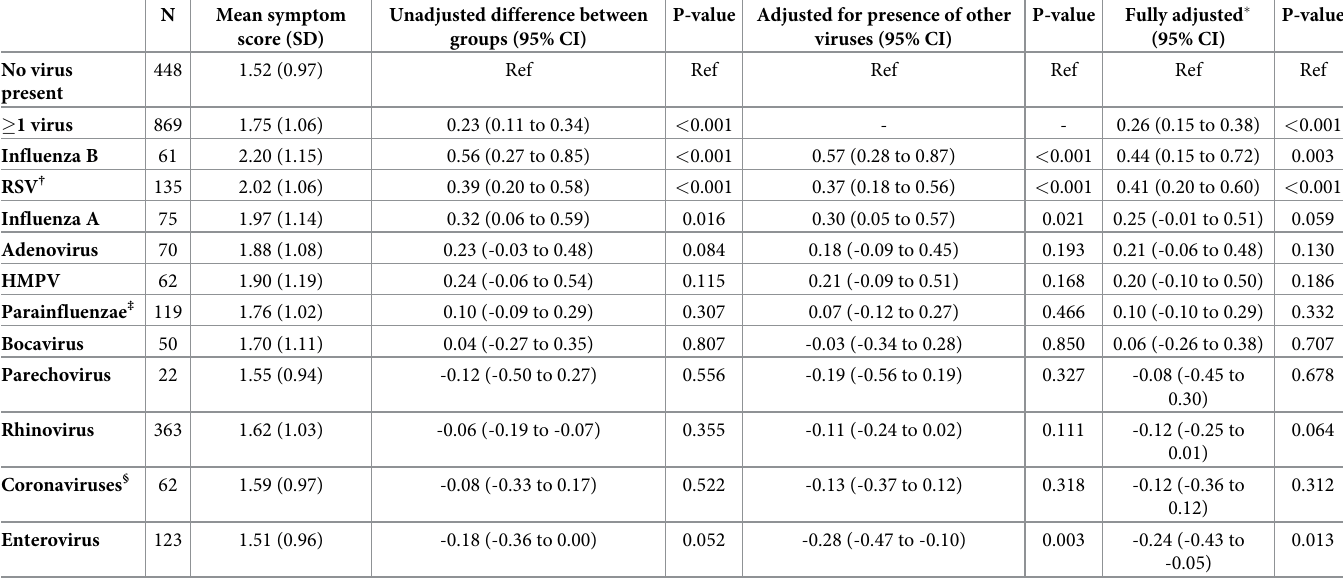
Table 2. Mean symptom severity between days 2–4 after initial illness presentation among children testing positive for respiratory